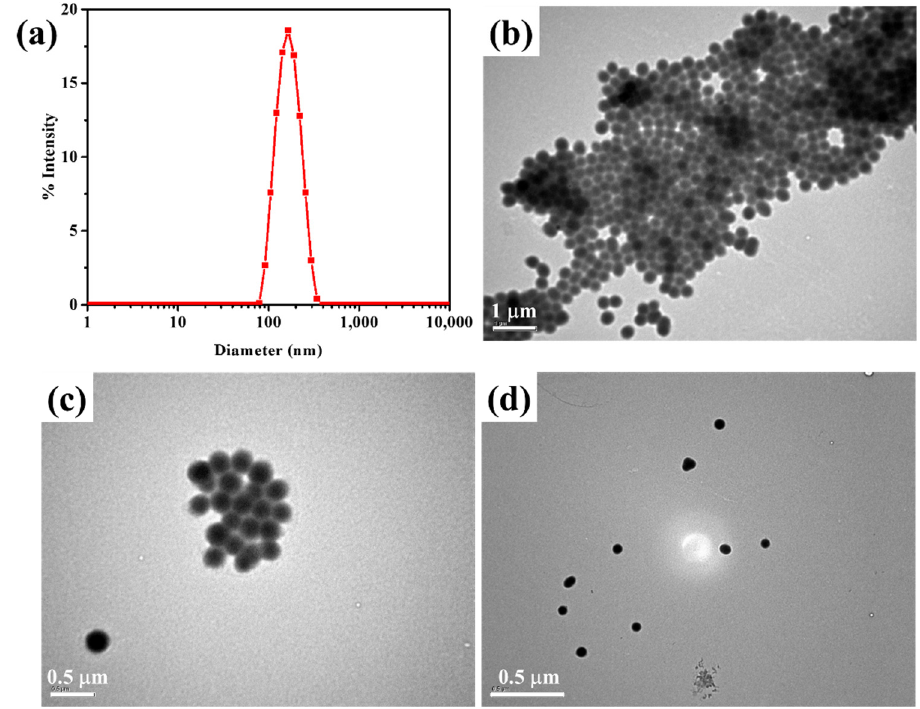
Figure 2. ( a ) DLS size distribution of nanogels; ( b – d ) TEM images of Cys-BIS-P(VCL-HEA) nano- gels.